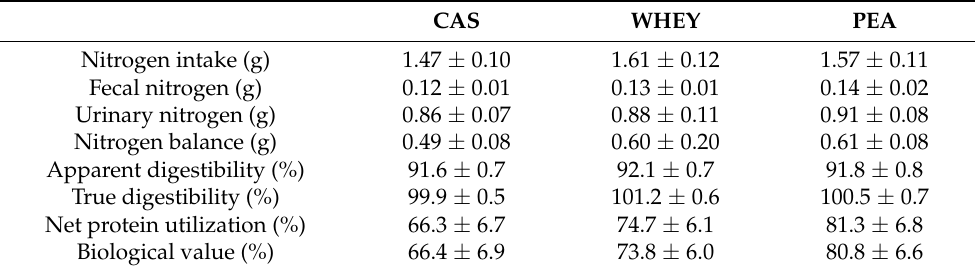
Table 6. Evaluation of the protein quality of the different experimental diets during the 4-day period in metabolic